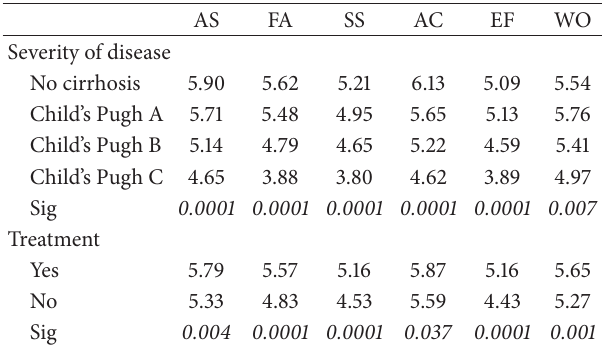
Table 5: Comparisons of CLDQ scores according to the severity of liver disease and receipt of treatment. AS